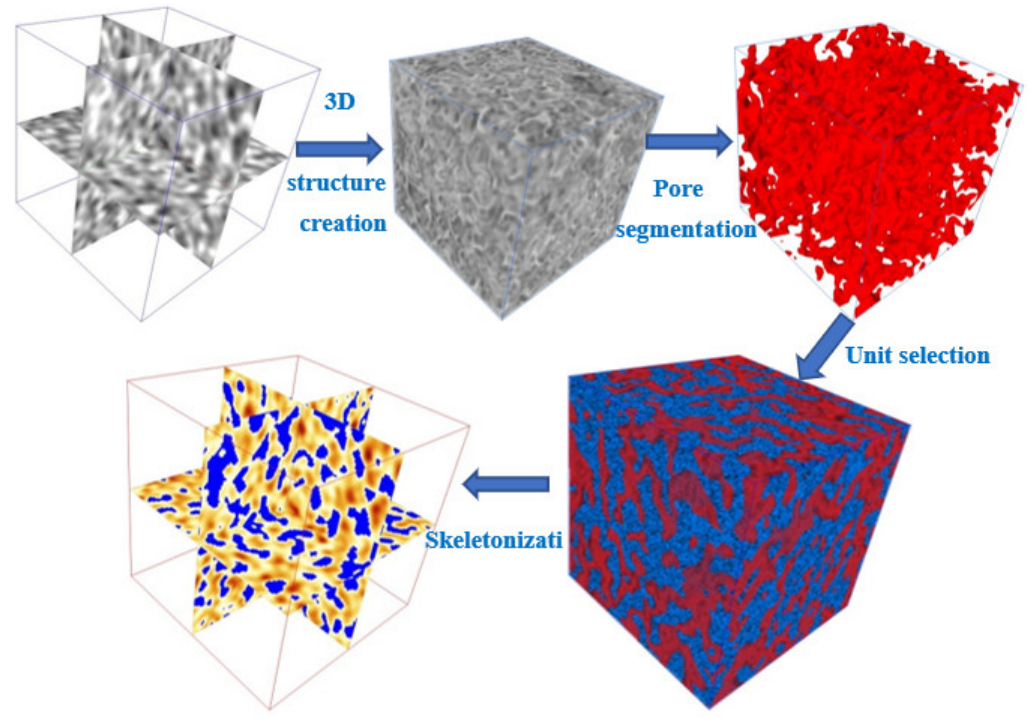
Figure 4. 3D model reconstruction process. A three-dimensional digital core is created, as shown in Figure 5.